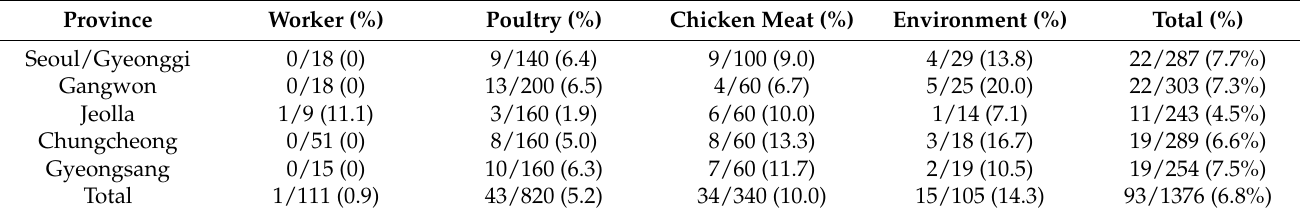
Table 1. Positive rates of ESBL-EC from poultry industry-related samples.